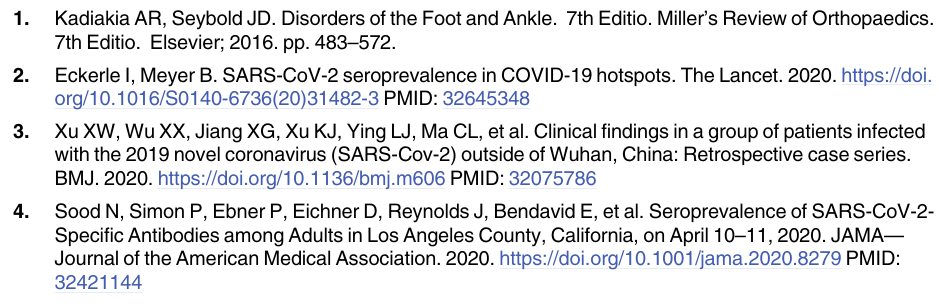
S1 Table. List of examined comorbidities and the corresponding ICD-10 diagnostic codes used to define each. S2 Table. List of examined adverse events and the corresponding ICD-10 diagnostic codes used to define